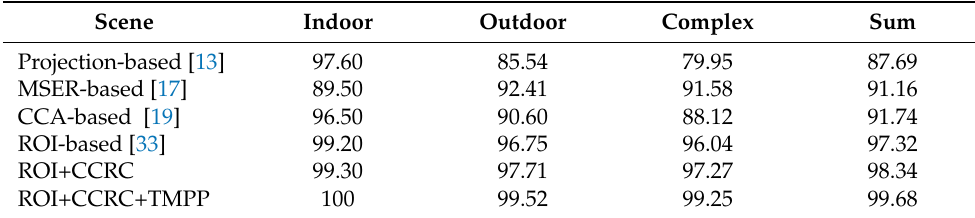
Table 2. Quantitative segmentation comparison (%) between our method and the compared ap- proaches. The strategy used in our method is ROI+CCRC+TMPP.